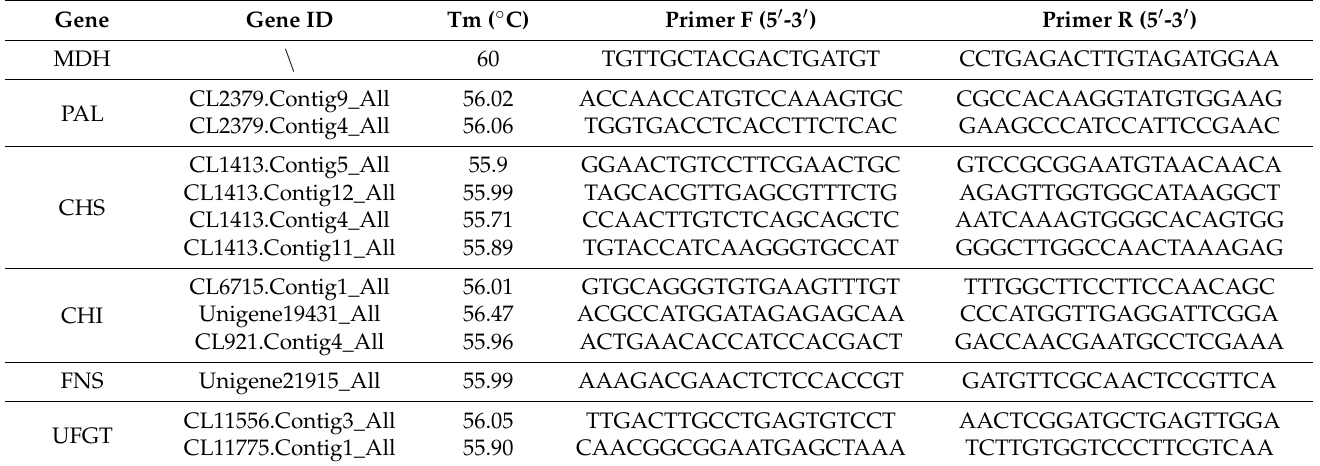
Table 3. Primer sequences of flavonoid-related genes in different parts of T. hemsleyanum